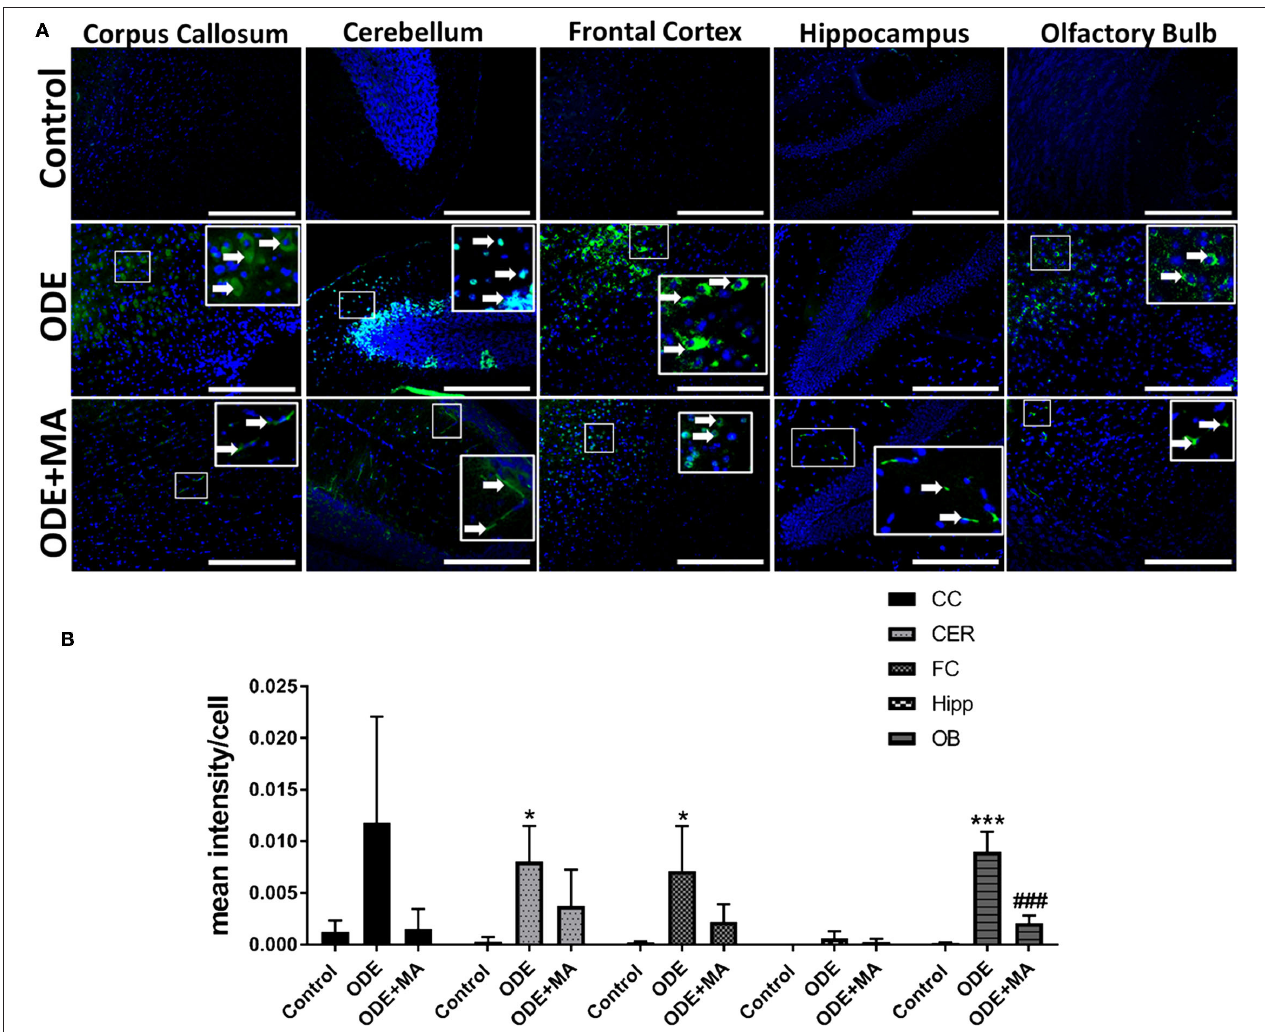
FIGURE 3 | ODE induces 3-Nitrotyrosine generation in various regions of mice brain. Paraffin-embedded sections from perfused mice brain were stained with anti-3-nitrotyrosine (NT; white arrow; Fluorescein isothiocyanate, FITC; green) antibody and nuclei were identified with DAPI (blue) (A) . 3-NT generation in IHC was quantified by a blinded investigator. Compared to control, ODE-exposed mice showed higher amounts of 3-NT staining in the cerebellum, frontal cortex, and olfactory bulb of the brain. MA (C11) treatment significantly reduced 3-NT generation only in olfactory bulb area of the brain (B) ( n = 5, *exposure effect, **indicates a significant change with respect to control, # MA treatment effect, ## indicates significant change with respect to MA (mitoapocynin), p < 0.05, micrometer bar = 50 µ